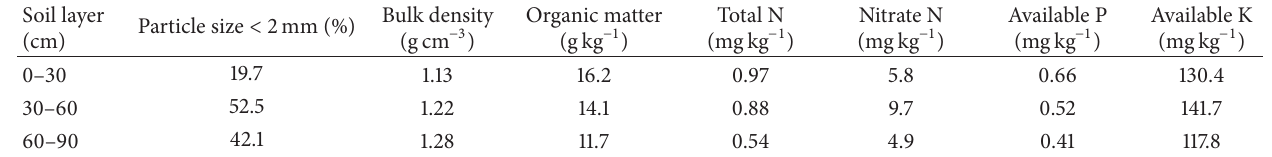
Table 1: The contents of organic matter, available N, available P, and available K of experimental soil. Soil